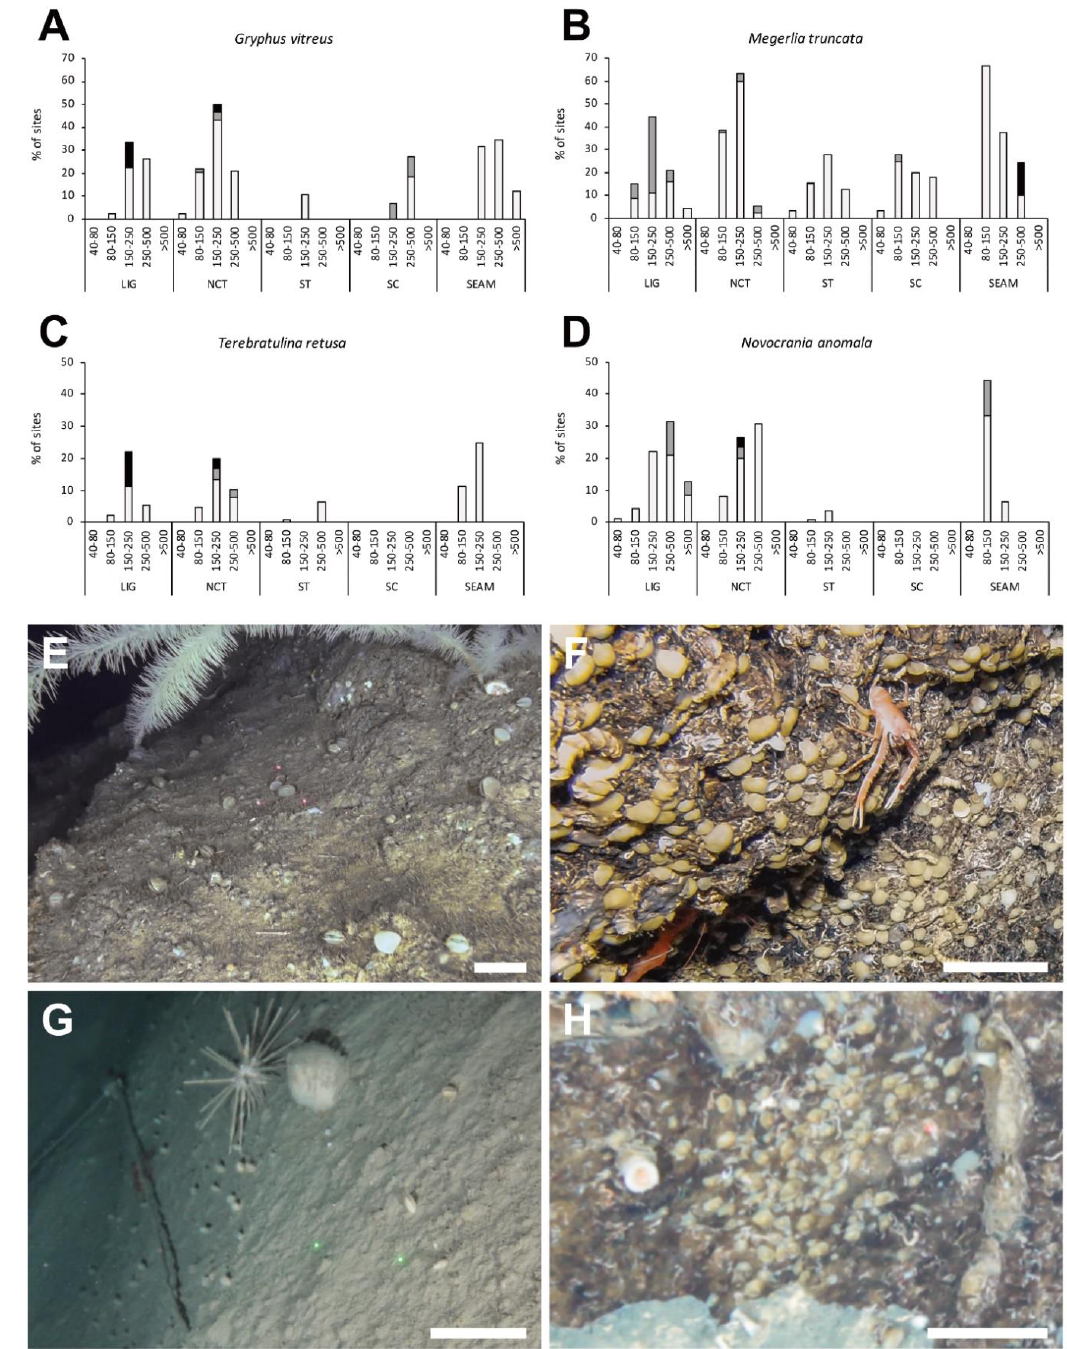
Figure 7. Populations’ relative abundance. ( A – D ) Percentage of sites with populations of different densities for each species in the five considered macro-areas and depth ranges. The colours of the stacked bars indicate the percentage number of sites with populations characterised by rare, scattered individuals (light grey), common, aggregated (dark grey), and abundant, dense specimens (black). ( E – H ) Examples of dense patches (relative abundance 3, abundant) of the target brachiopods: ( E ) Gry- phus vitreus (Montecristo Island, northern Tyrrhenian Sea, 160 m); ( F ) Megerlia truncata (Etruschi Seamount, northern Tyrrhenian Sea, 385 m); ( G ) Terebratulina retusa (Bordighera Canyon, western Ligurian Sea, 165 m); ( H ) aggregation of juvenile and adult individuals of N. anomala (Pontine Archipelago, central Tyrrhenian Sea, 190 m). Scale bar: 10 cm ( E , G ), 5 cm ( F , H